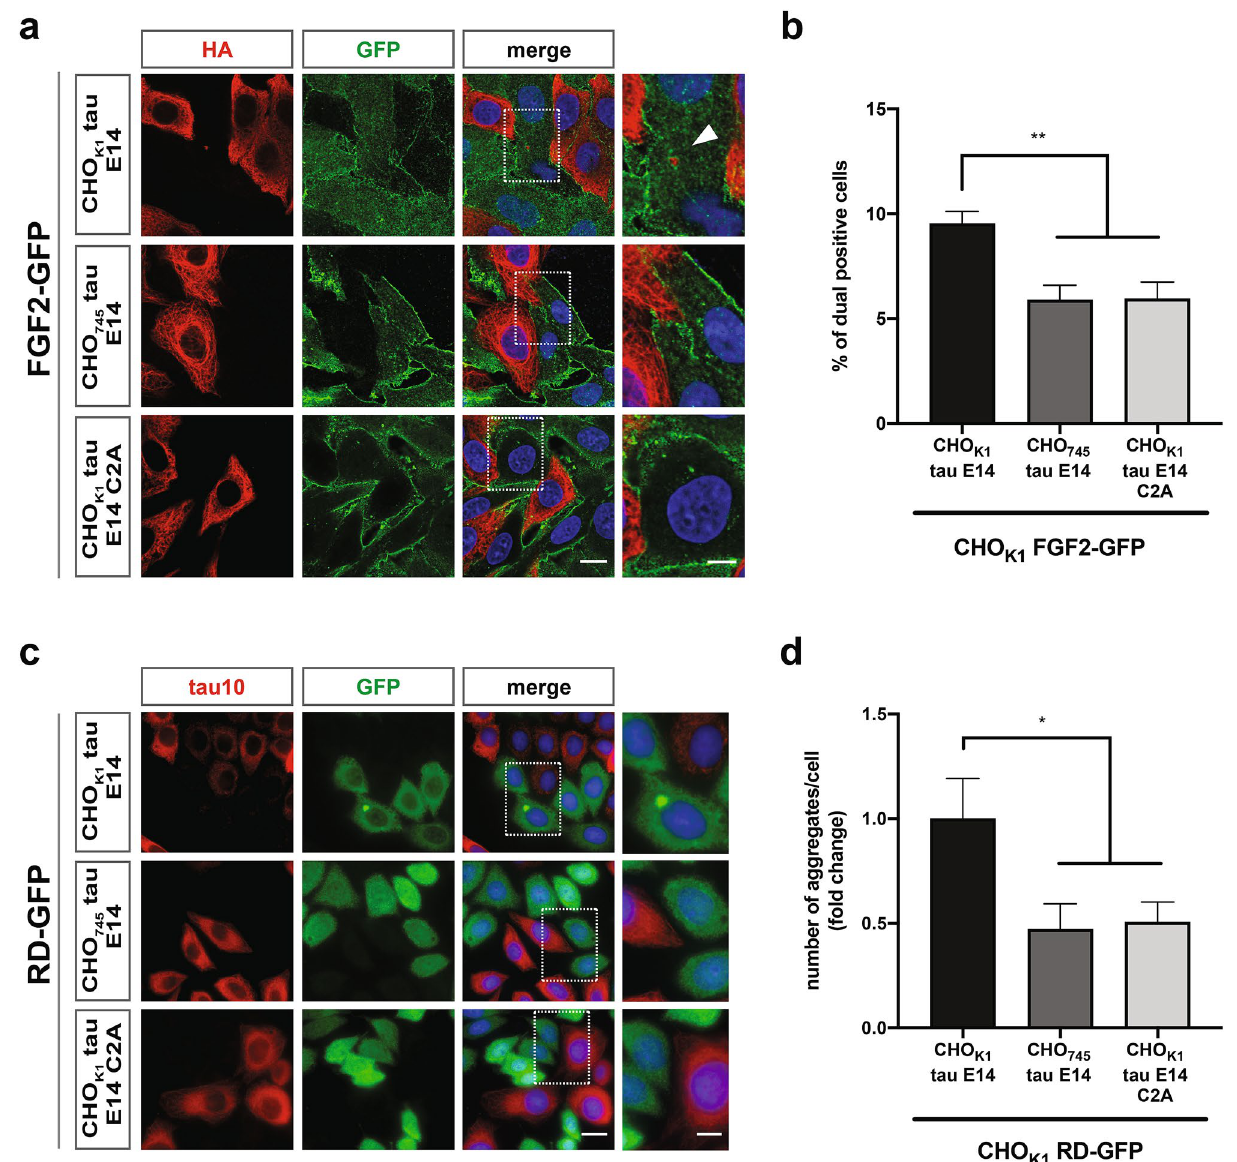
Figure 6. The availability of cysteines drastically influences the trans-propagation of tau. (a) CHO K1 cells expressing either tau E14 or tau E14 C291/322A were co-cultured with FGF2-GFP cells for 48 h and were subsequently stained for tau, FGF2, and nucleus using antibodies against HA, GFP, and the Hoechst dye, respectively (scale bars, 10 µm and 3 µm for the magnified image). (b) The tau-positive signal inside FGF2- GFP cells was quantified through an image-based analysis (3 independent biological replicates with at least 400 processed cells per case). The data represent mean values ± s.d. and were statistically analysed through one-way ANOVA followed by Tukey’s post hoc analysis. (c) CHO K1 RD-GFP cells were co-cultured with CHO K1 tau E14, CHO 745 tau E14, and CHO K1 tau E14 C291/322A cells. All combinations were stained with tau10 and GFP antibodies for full-length tau and RD-GFP detection, respectively. Hoechst dye was used for nuclear staining. Scale bars correspond to 15 µm and 5 µm for the original and magnified images, respectively. (d) The RD-GFP positive inclusions were quantified through a semi-automated image analysis of randomly selected z-projected scans and the number of inclusions/cell for each condition was compared to the CHO K1 tau E14-CHO K1 RD-GFP co-culture combination (3 independent biological replicates with at least 330 processed cells per case). The data represent mean values ± SEM and were statistically analysed through one-way ANOVA followed by Tukey’s post hoc